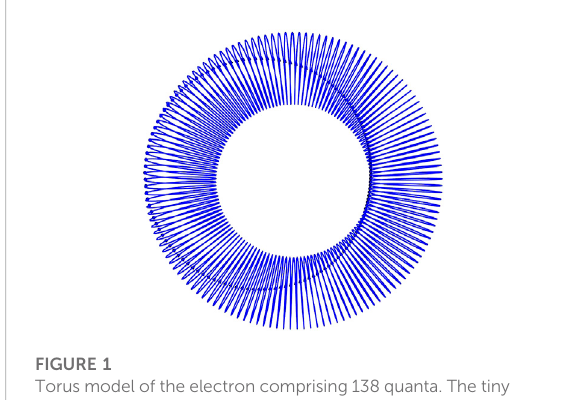
FIGURE 1 Torus model of the electron comprising 138 quanta. The tiny arrow of each quantum indicates the sense of circulation (Illustration by